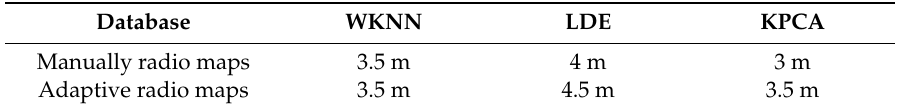
Table 2. Positioning error with confidence probability 90% of three algorithms for two di ff erent databases in Experiment